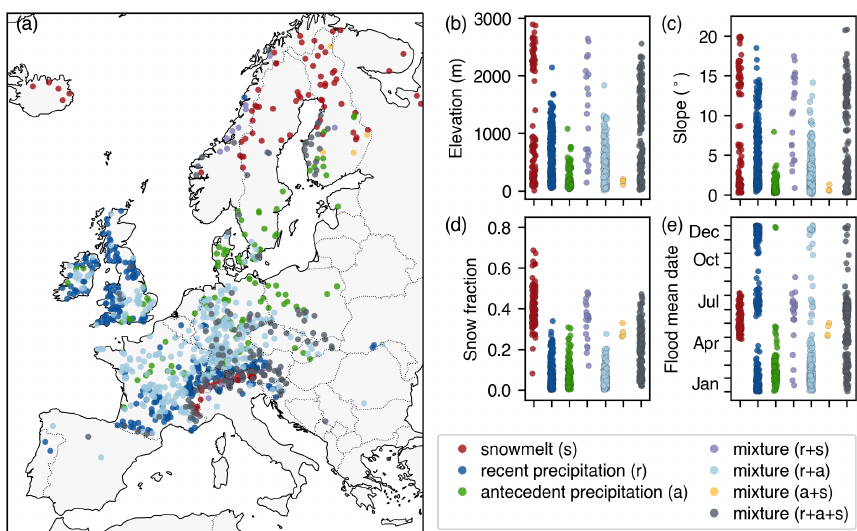
Figure 6. The dominant flooding mechanisms and their relevance to catchment attributes and seasonality. Each dot in (b) – (e) represents one catchment. “Mixture means” the associated catchments are dominated by two or more flooding mechanisms. For example, “mixture ( r + s )” indicates that either recent precipitation ( r ) or snowmelt ( s ) is the primary cause of the annual maximum discharges for the associated catchments, and the difference between the two proportions is less than